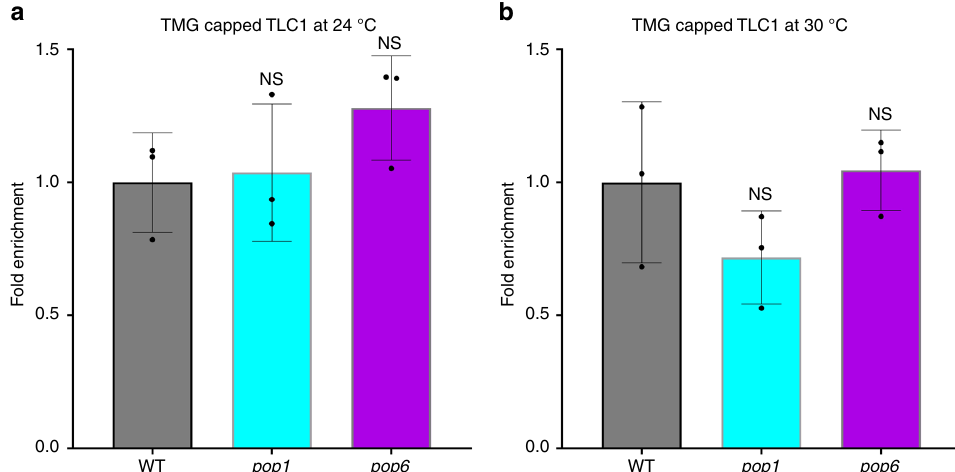
Fig. 5 Trimethylation of the TLC1 5 ′ cap is not affected in pop cells. Total RNA was extracted from WT (gray bars), pop1 (blue bars) and pop6 (purple bars) cells and TMG-capped TLC1 was immunoprecipitated using an anti-TMG antibody in cells grown at 24 °C ( a ) or 30 °C ( b ). TLC1 in the immuno- precipitate was measured by RT-qPCR. IP/INPUT TLC1 was normalized to IP/INPUT ACT1 mRNA. Bars are data from three independent biological isolates (black circles). Error bars are one standard deviation from the average value of three or more independent experiments. P-values were calculated using unpaired two-tailed Student ’ s t -test; * P ≤ 0.05 , ** P ≤ 0.01, *** P ≤ 0.001, **** P ≤ 0.0001; NS, not signi fi cant, P >0.05. Source data are provided as a Source Data fi